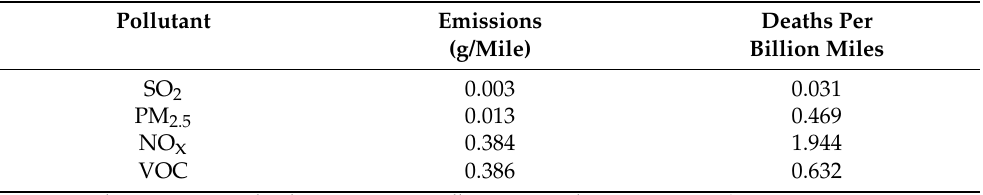
Table 1. U.S. light duty vehicle fleet emissions rates and expected death rates.